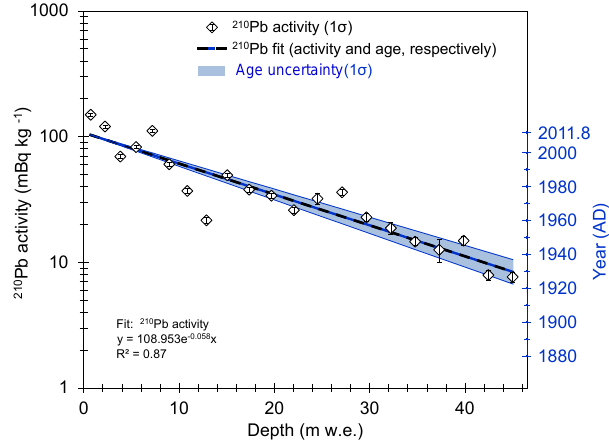
Figure 9. Measured 210 Pb activity (left y axis, logarithmic scale) and calculated age (right y axis) vs. depth (in metres of water equiv- alent) relationship in the Mt. Ortles core no. 2. The fit is also re- ported for 210 Pb activity (logarithmic, black) and age (linear, blue); the latter is shown with its 1 σ confidence interval (in